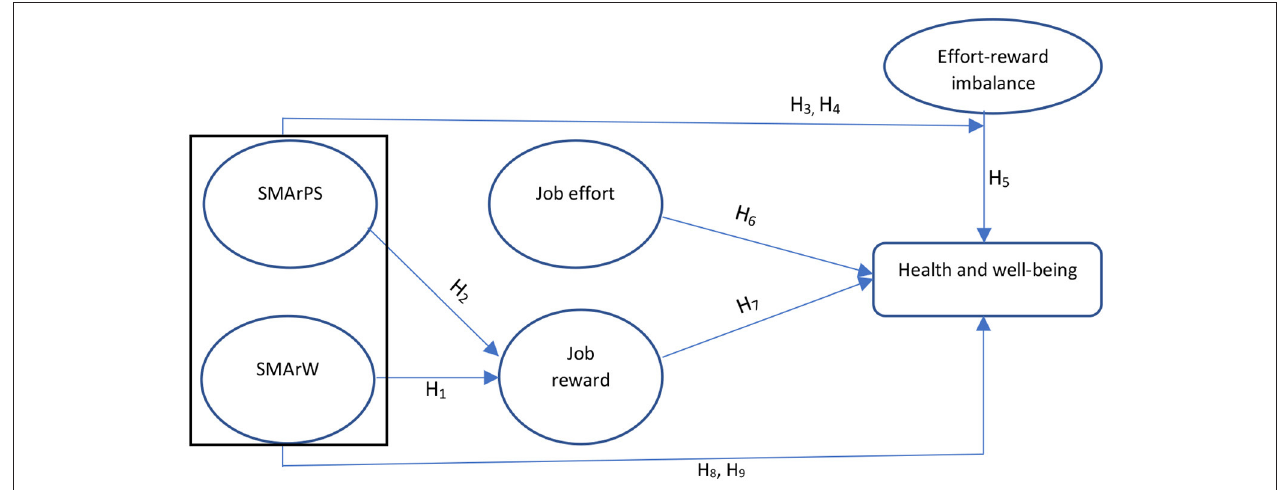
FIGURE 1 | The conceptual framework: Social media activities moderating the association between effort-reward imbalance and health &